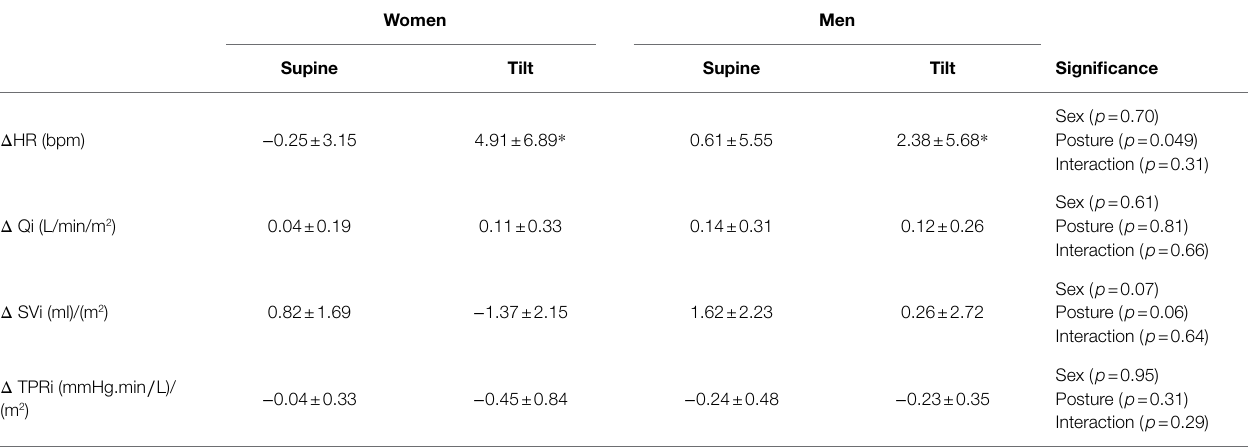
TABLE 5 | Hemodynamic changes from baseline to the time of maximal hyperemia of women and men across the supine and tilt in the EndoPAT testing. Women Men Supine Tilt Supine